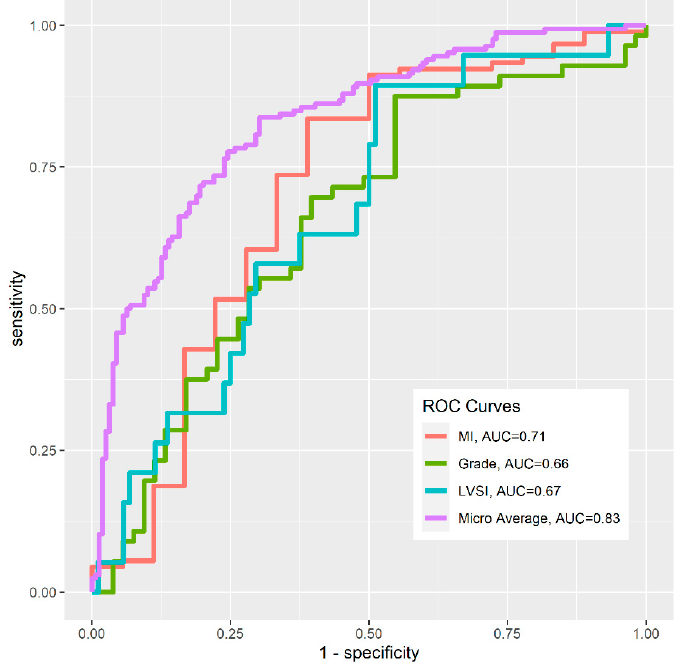
Figure 6. Receiver operating characteristic (ROC) curves for three classification models (MI, Grade and LVSI) and their micro-average. and LVSI) and their